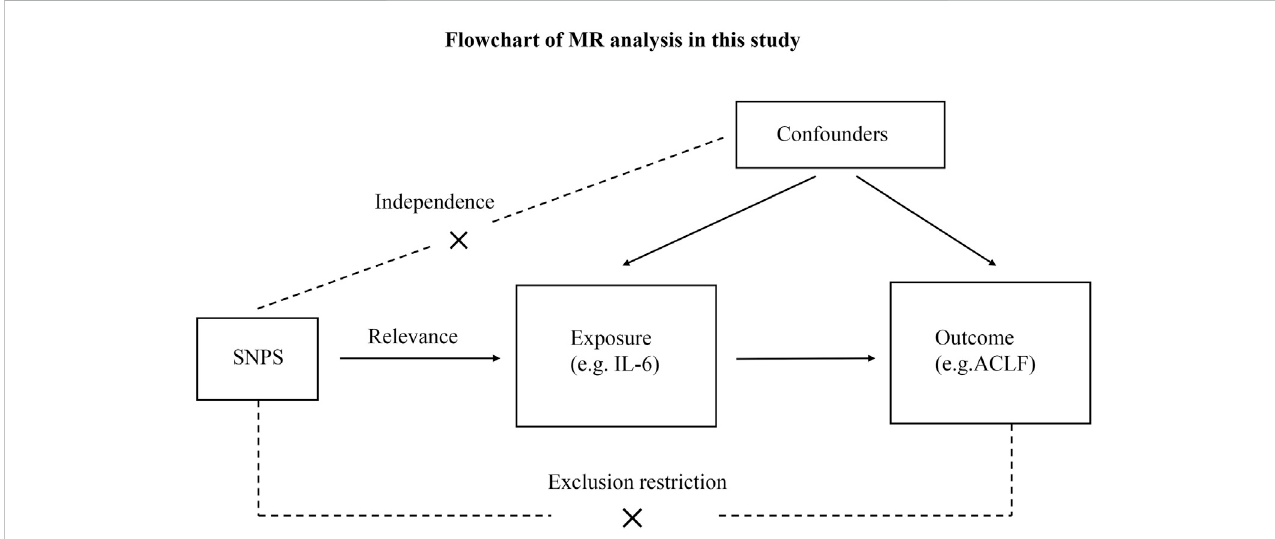
Flowchart of MR analysis in this study. ACLF, Acute-on-chronic liver failure; SNPs, single-nucleotide